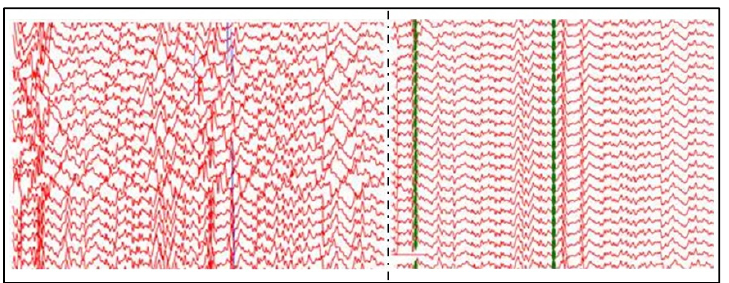
Figure 5. Track geometry data, prior to (left) and following alignment (right).